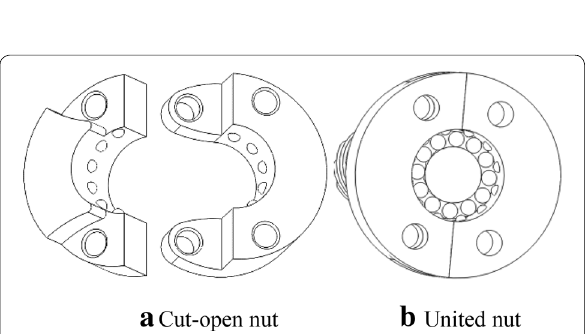
Figure 12 Broken strand repositioning component (This figure is reprinted with permission from Ref. [26], Copyright (2015) Elsevier)